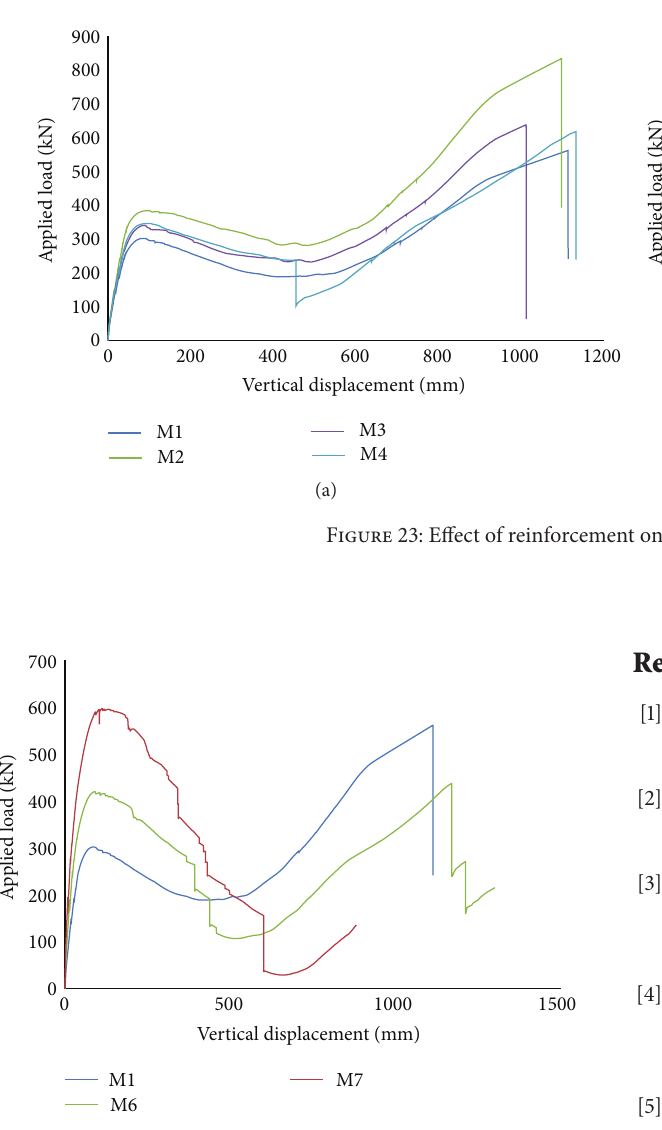
Figure 24: Effect of beam geometry on load-displacement curve with same